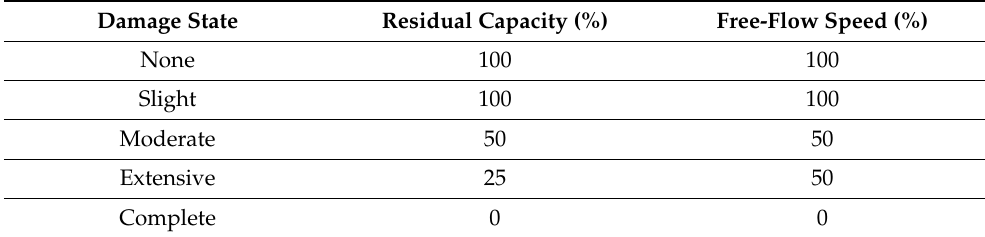
Table 13. Residual traffic carrying capacity and free-flow speed reduction.